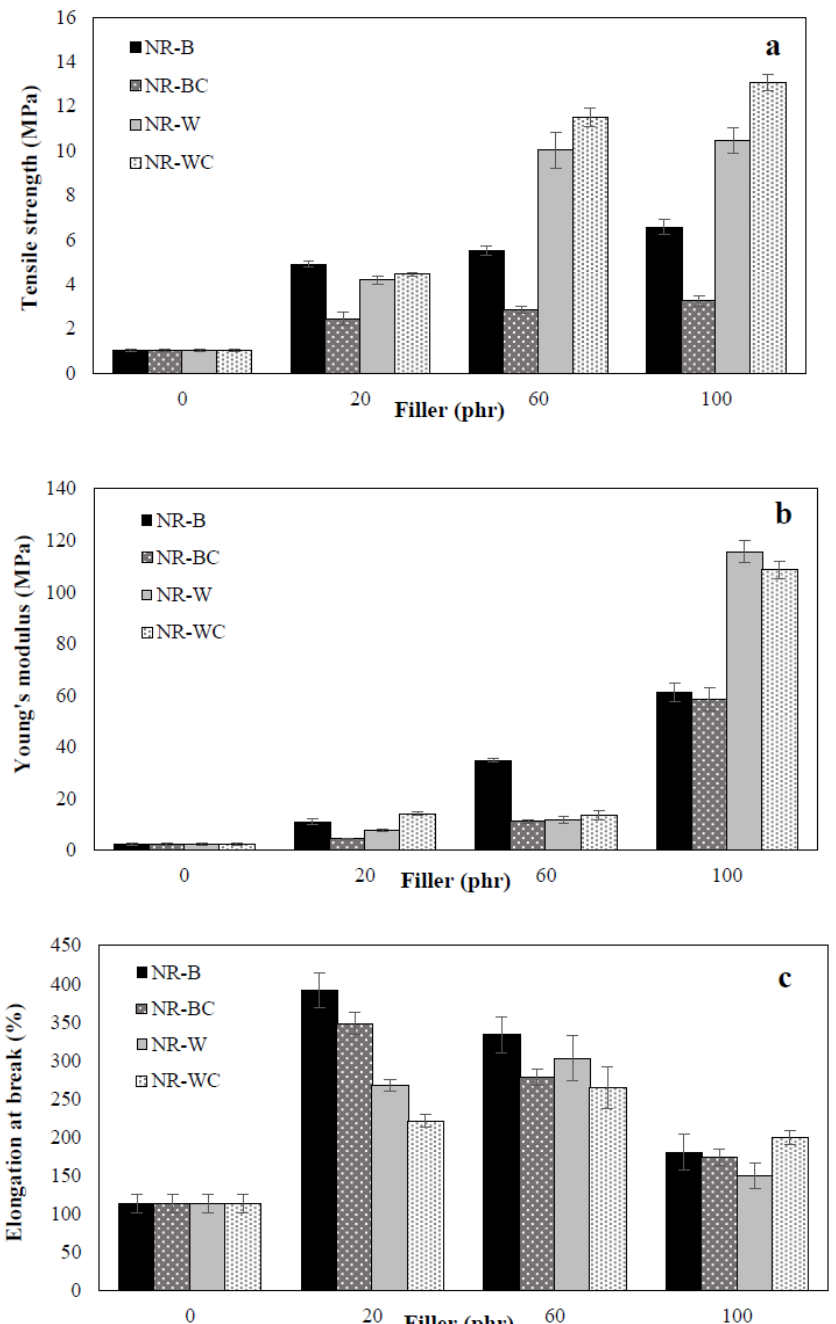
Figure 7. Mechanical properties, tensile strength ( a ), Young’s modulus ( b ) and elongation at break ( c ) of NR, NR–B, NR–BC, NR–W and NR–WC composite with filler loading content at 0, 20, 60 and 100 phr .